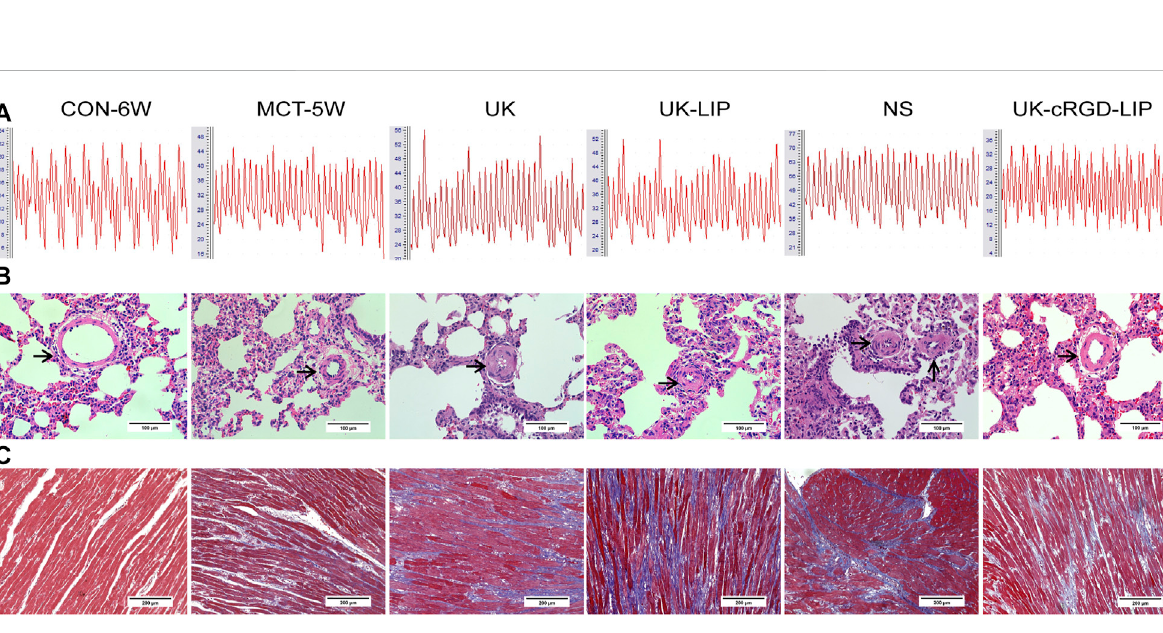
FIGURE 6 (A) Representative pulmonary artery pressure wavaforms obtained from CON-6W, MCT-5W, UK, UK-LIP, NS, and UK-cRGD-LIP rats. (B) Representativeimages(×400originalmagni fi cation)ofH&EstainingoflungtissuesfromCON-6W,MCT-5W,UK,UK-LIP,NS,andUK-cRGD-LIP rats. Black arrow points to pulmonary arteriole (20 – 100 μ m diameter). (C) Representative images (×200 original magni fi cation) of Masson ’ s trichrome staining of RV tissues from CON-6W, MCT-5W, UK, UK-LIP, NS and UK-cRGD-LIP rats. Red indicates muscle fi bers; blue indicates collagen fi